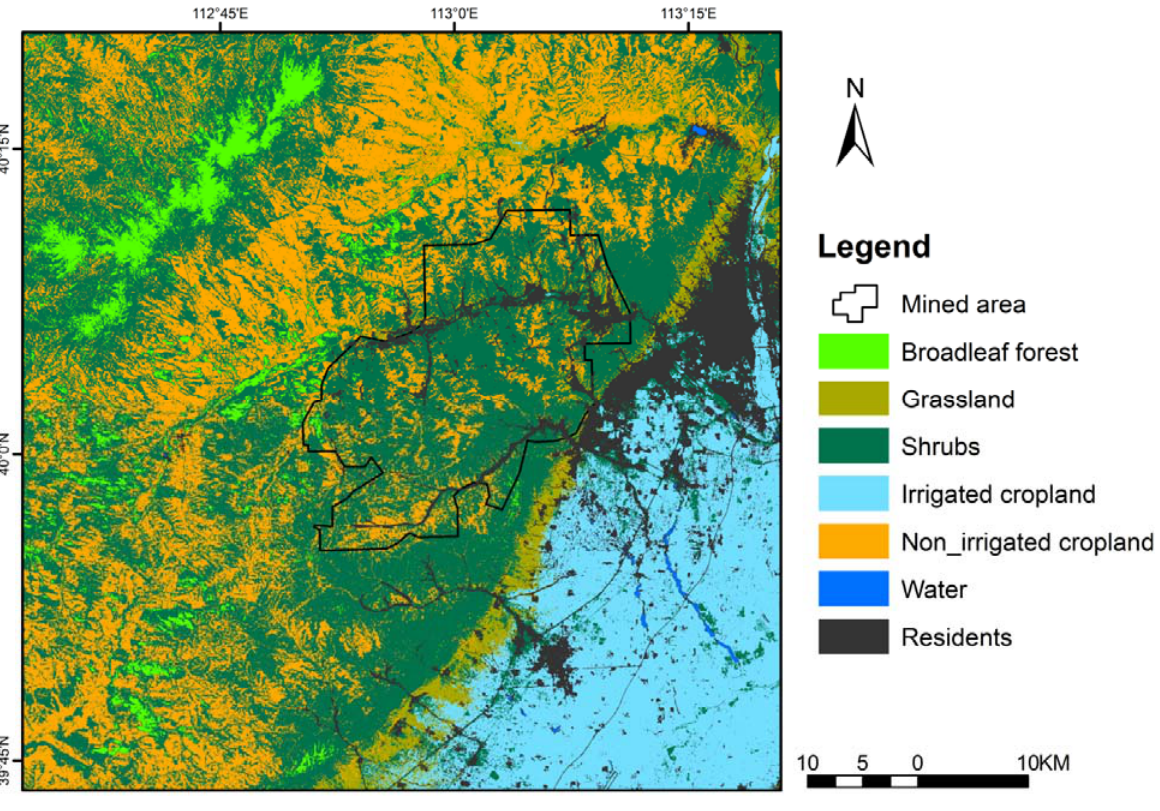
Figure 2. Land cover classification map of the study area (modified/adopted from Zhao et al .